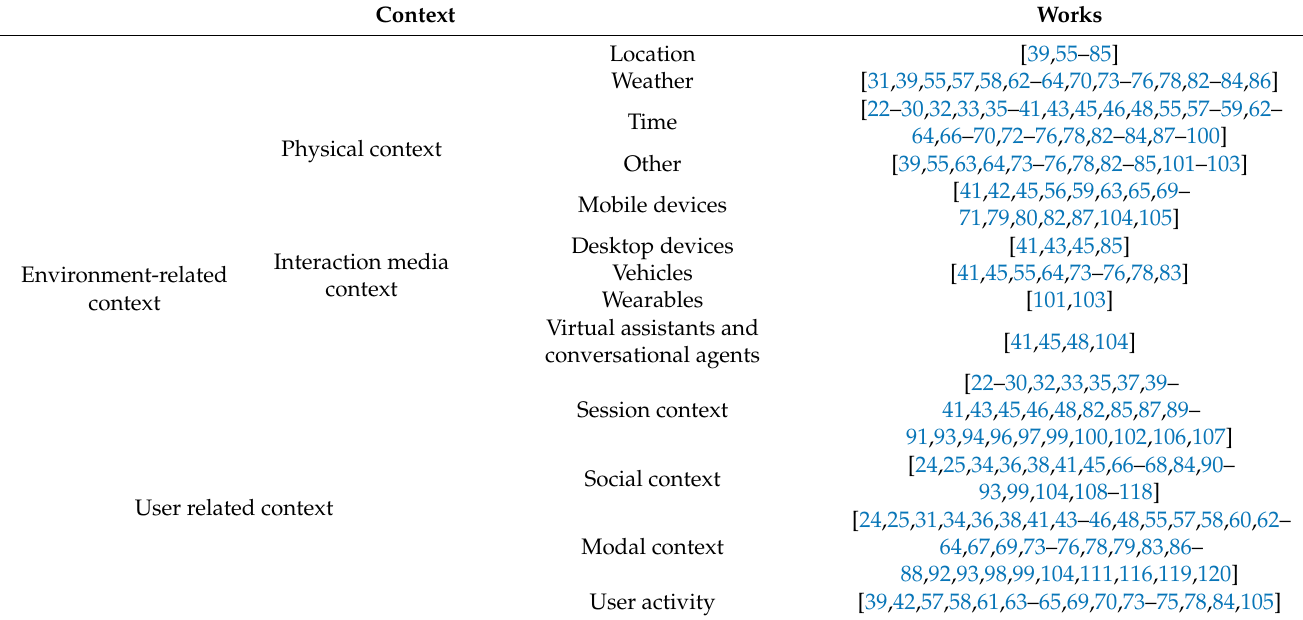
Table 2. Context classification of included works.